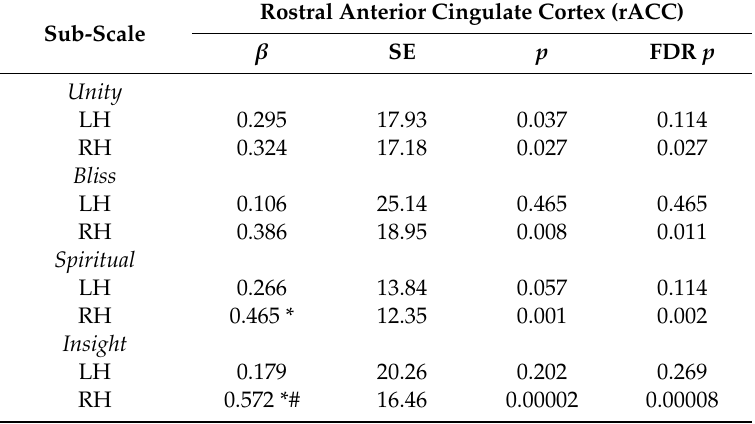
Table 2. Right Hemisphere Rostral Anterior Cingulate Thickness Predicts the Emotional Psilocybin Experience.